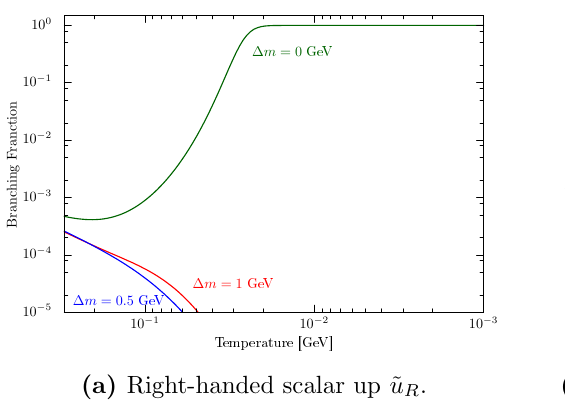
olation (cid:14) 13 = 10 (cid:0) 3 .